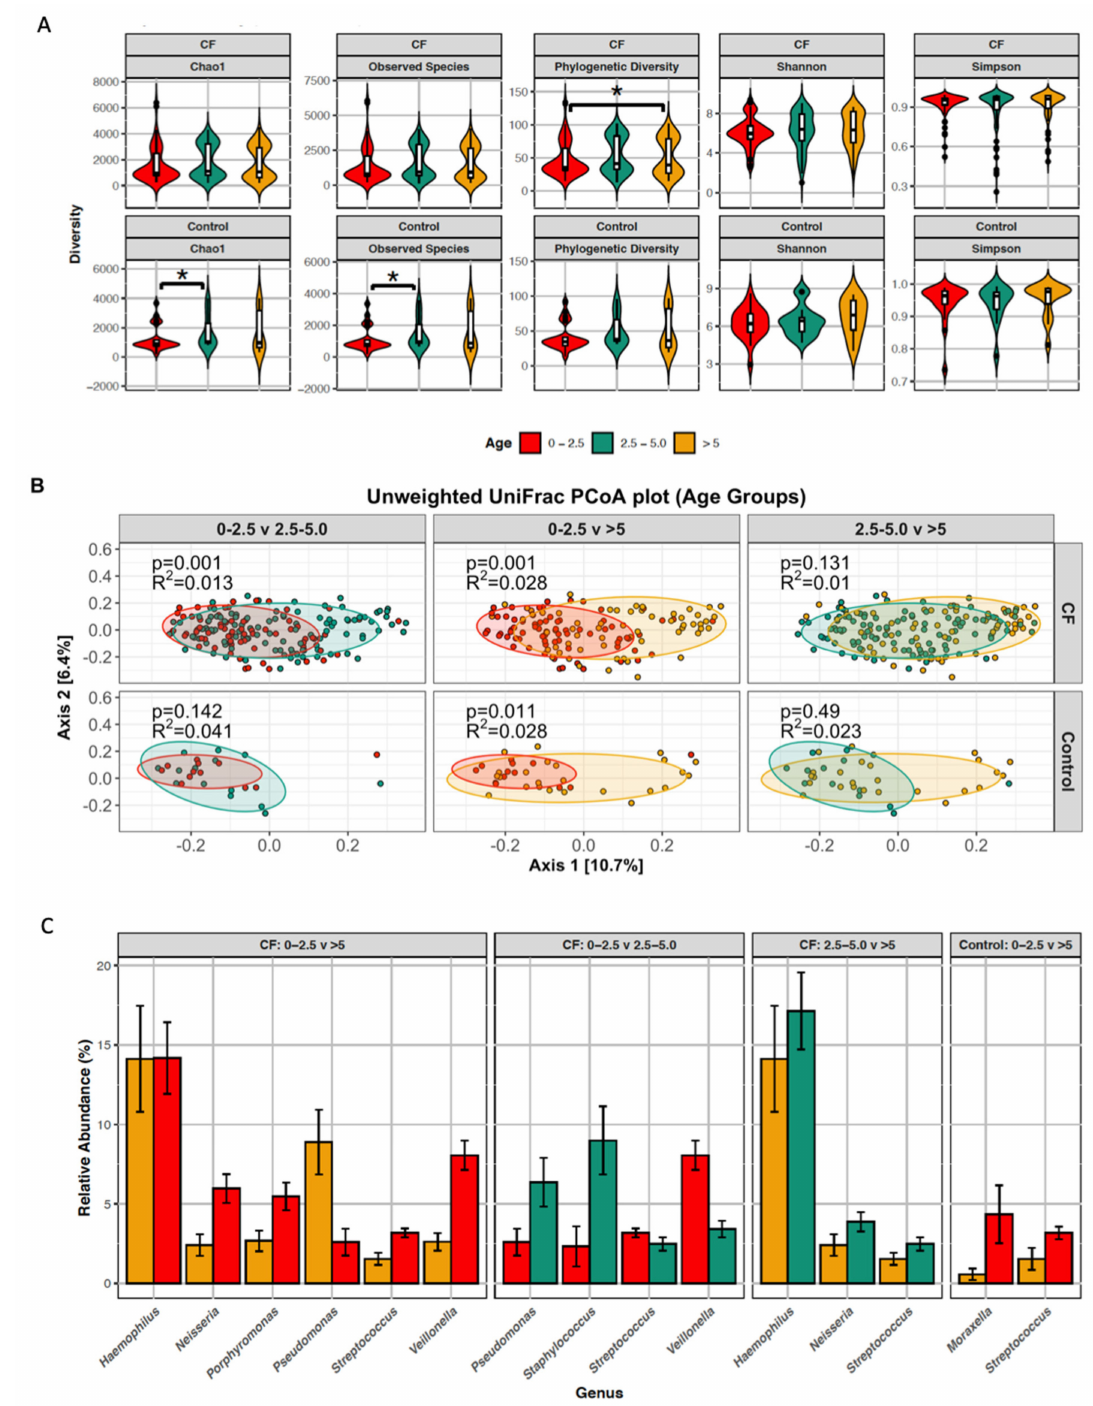
Figure 4. Age-associated changes in the microbiome of children with CF and without CF (control). ( A ) alpha diversity displayed as violin plots and ( B ) beta diversity displayed as unweighted UniFrac PCoA plots (ellipses illustrate 80% confidence intervals) of the lower airway microbiota across three age groups: 0 to 2.5 years old, 2.5 to 5 years old and over 5 years old. ( C ) Genera which were significantly differentially abundant (i.e., LDA >4.0) across these same groups, as determined using